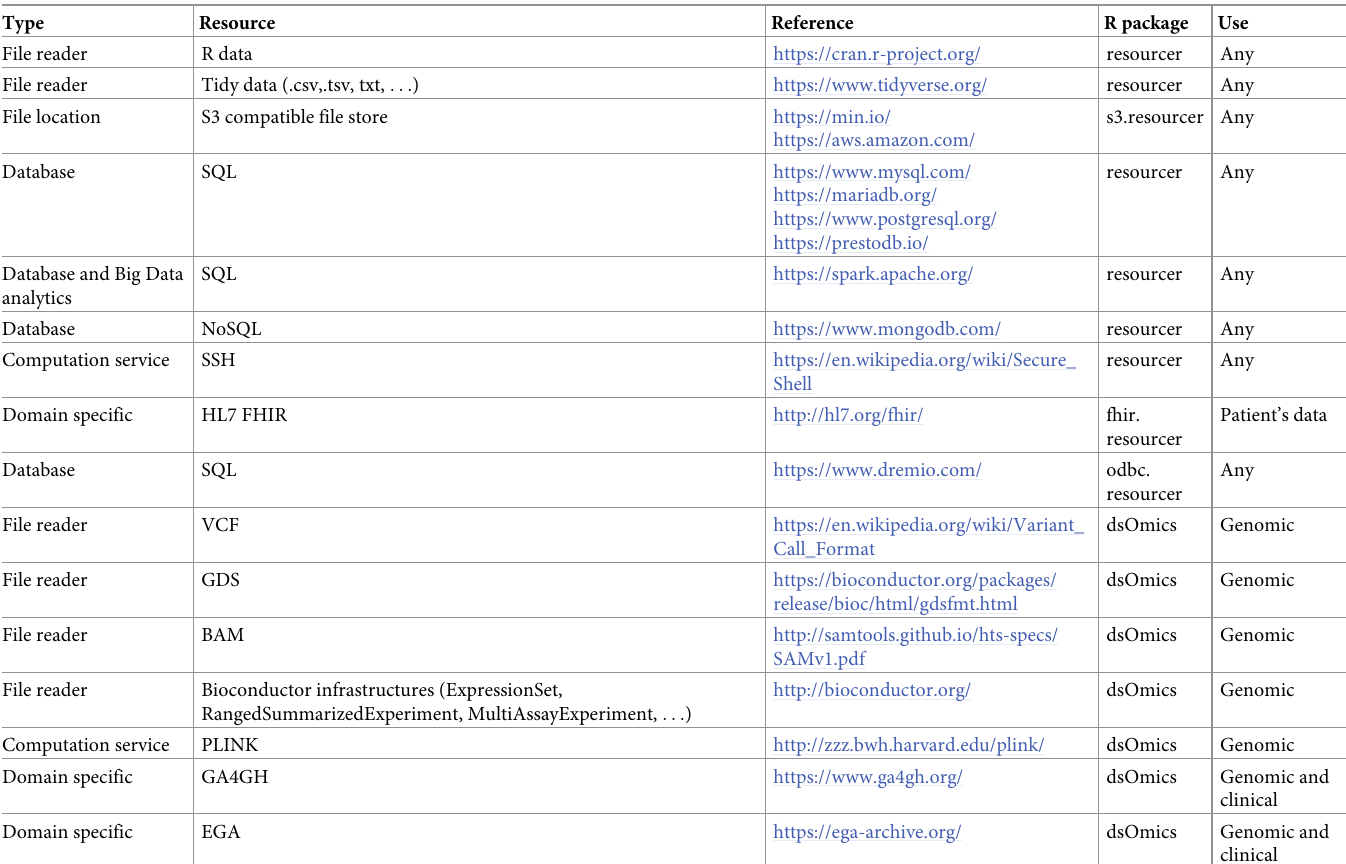
Table 2. Available resources at the resourcer R package and extensions for genomic